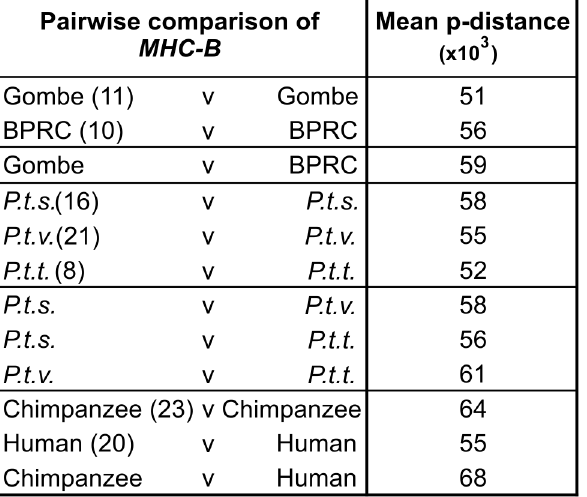
Fig 4. Sequence diversity of the polymorphic exons of chimpanzee and human MHC-B alleles. Pairwise nucleotide differences (p-distances) in the sequences of exons 2 and 3 were calculated for each set of comparisons listed. “ P.t.s. ” is P. t. schweinfurthii ; “ P.t.v. ” is P. t. verus ; “ P.t.t. ” is P. t. troglodytes . The number of alleles in each set being compared is given in parentheses. Histogram distributions and statistics are given in S4 Fig. The alleles used to generate the p-distances are listed in S6 Fig, and their sequences are included in S2